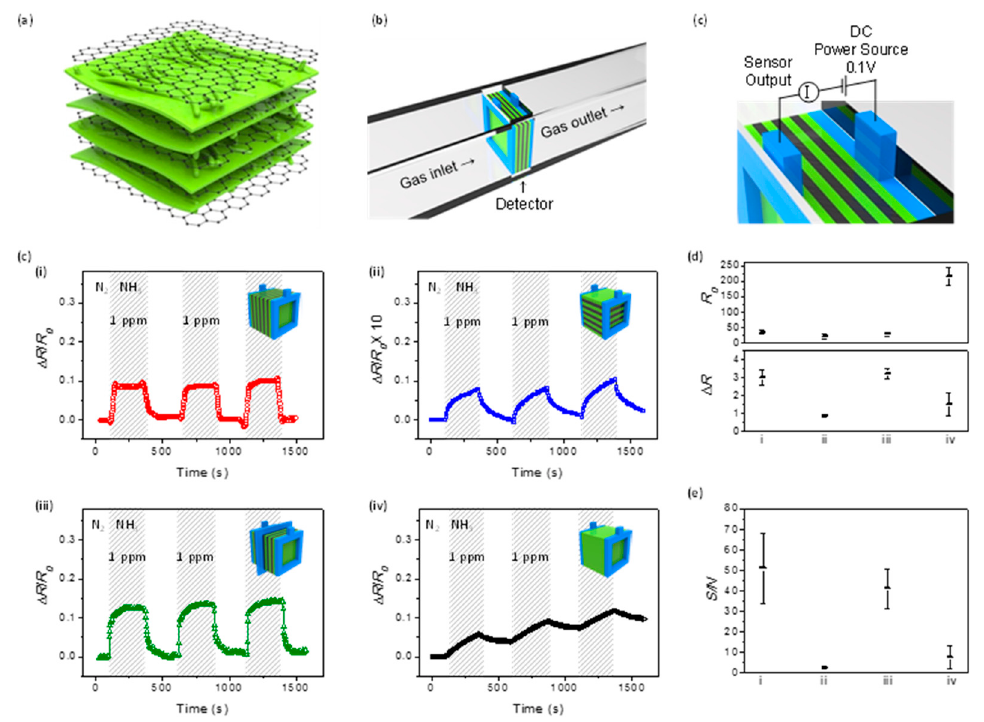
Figure 11. Schematic illustration of ( a ) G-t-PANI film; ( b ) gas flow and electrical setup for the chemical gas sensor; ( c ) sensing performance of a G-t-PANI film with various stacked orientation toward 1 ppm NH 3 gas. (( i ) a series type, ( ii ) a parallel type, ( iii ) a combination type connected with two series films of half-thickness, and ( iv ) a bulk t -PANI film); ( d ) initial ( R 0 ) and change ( ∆ R ) of resistance in resistometric sensor; ( e ) signal-to-noise ratio under the same conditions. Reprinted with permission from [89]. Copyright 2016, American Chemical Society.